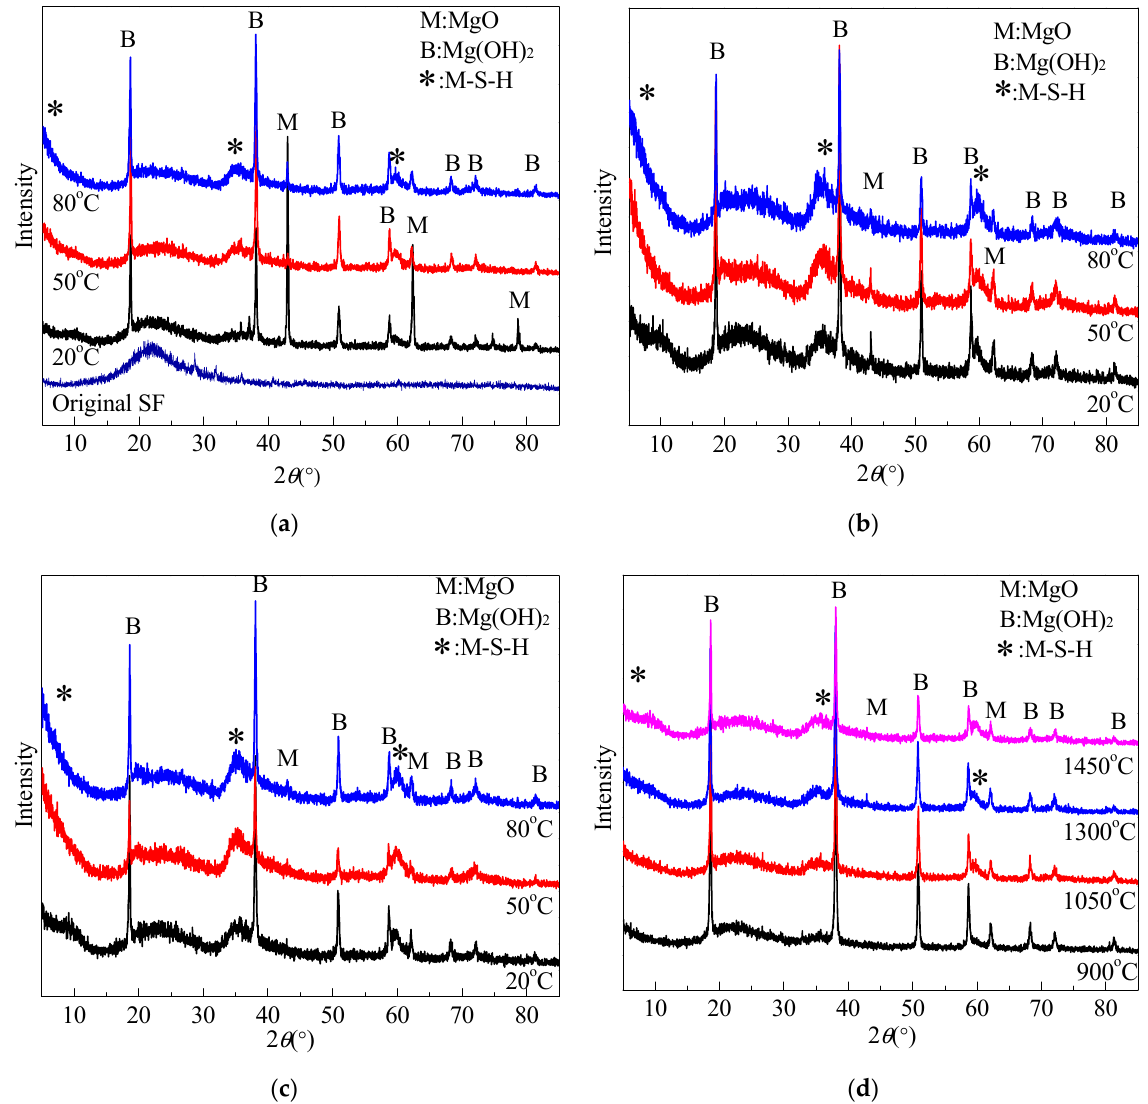
Figure 8. XRD patterns of MgO-SF pastes and SF (MgO was calcined at different temperatures for 30 min): ( a ) SF and MgO calcined at 1450 °C, cured for 3 d; ( b ) MgO calcined at 1450 °C, cured for 14 d; ( c ) MgO calcined at 1450 °C, cured for 28 d; and ( d ) MgO calcined at different temperatures, cured at 20 °C for 28 d.